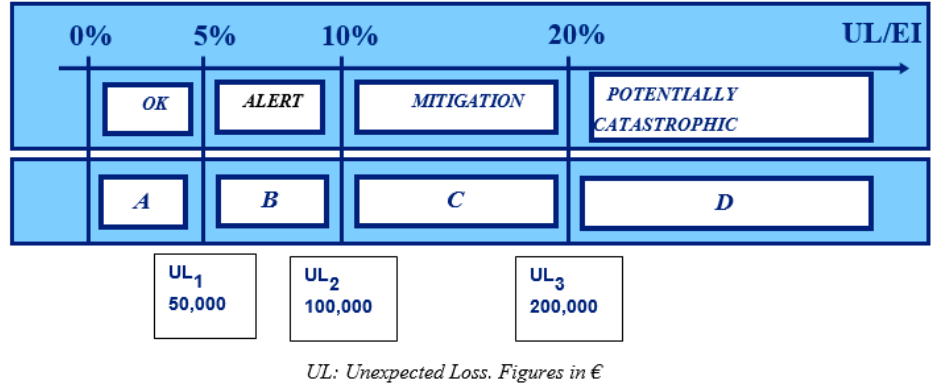
Figure 4. Assessment Ranges and Risk Thresholds. Source: author own study.